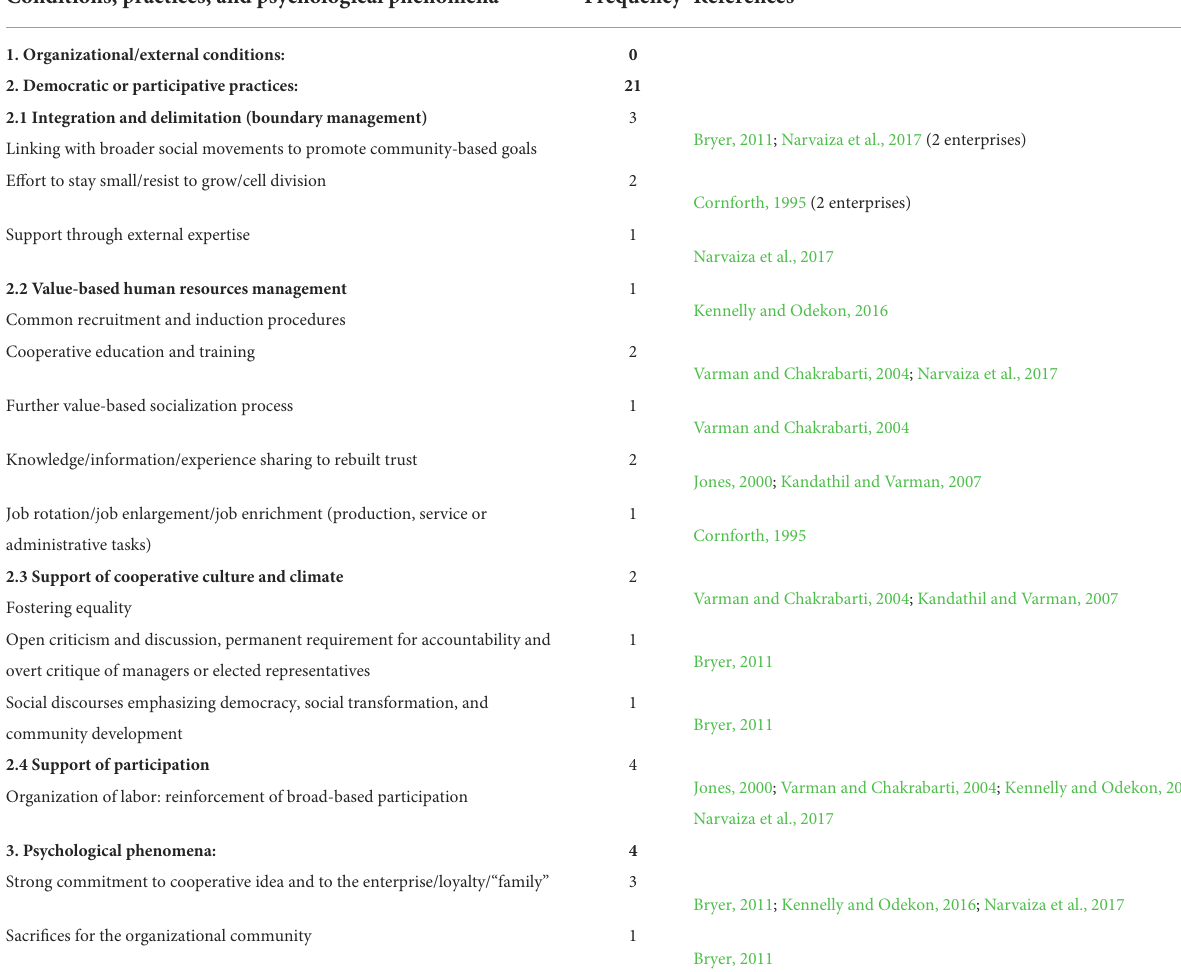
TABLE 5 Frequencies of conditions, practices and psychological phenomena of all forms of regeneration mentioned ( n = 8 enterprises). Conditions, practices, and psychological